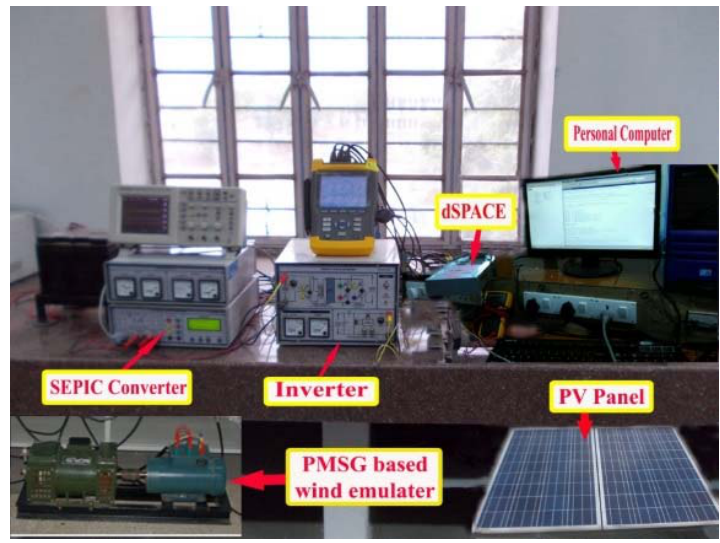
Figure 10. Developed experimental setup of the proposed hybrid micro grid system based on a real ‐ real-time digital simulator-dSPACE time digital simulator ‐ dSPACE platform.